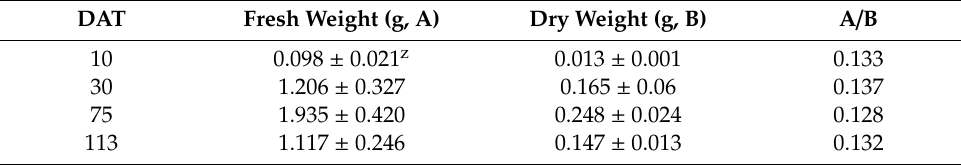
Table 1. Sampled fresh and dry weights of the roots specific days after transplanting (DAT).